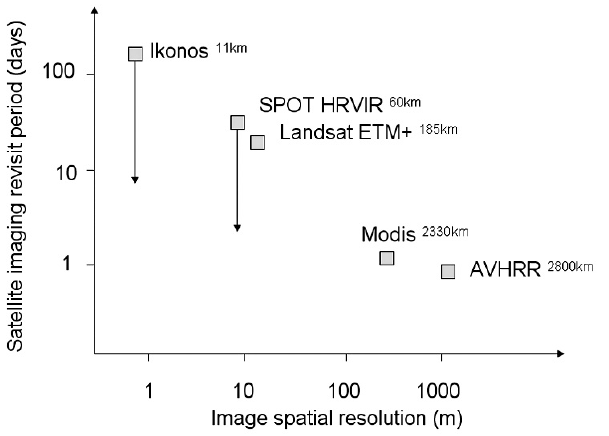
463-468Fig. 1. – Relationship between image spatial resolution and satellite imaging revisit period for selected sensors relevant to spatial epi- demiology. Superscripts indicate image swath width and arrows show range of satellite imaging revisit period using sensor off-nadir poin- ting